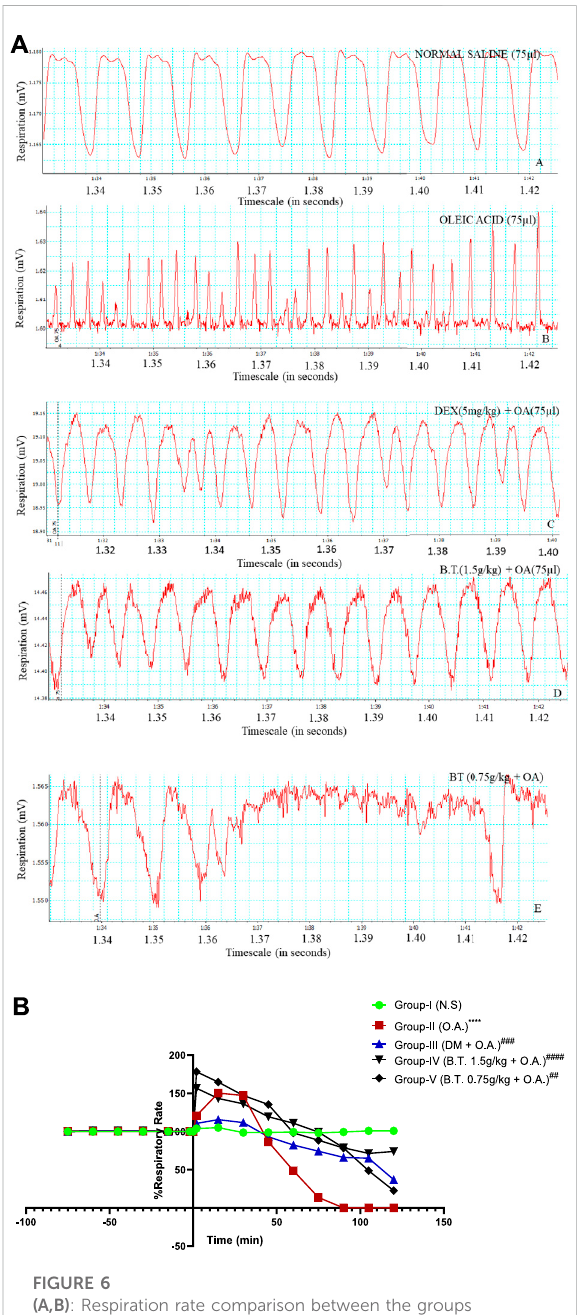
FIGURE 6 (A,B) : Respiration rate comparison between the groups through chart recorder (A) and statistically (B) . (A) : Respiration rate frequency denoted by red colour in real-time in groups I (A), II (B), III (C), IV (D) and V (E) at a 10:1 aspect ratio obtained from a computerized chart recorder where x -axis represents Respiration (mV) and y -axis represent timeline. Group I shows the basal value of RR, whereas tachypnea is prominent in group II. This was recti fi ed in treatment groups III and IV as near normal frequency canbeseenafterinstillationofoleicacid(denotedbyadottedline) instillation. (B) : Respiration rate calculated as percentage initial at 0 min(denotesthetimeofoleicacidinstillationexceptforgroupI). Results are expressed as mean ± SD (n = 6). Statistical analysis was carried out using one-sample T-test and Wilcoxon test where *, p < 0.05, ***, p < 0.001,****, p < 0.0001 in comparison to group I and # ,p < 0.05, ### ,p < 0.001 and #### ,p < 0.0001 in comparison to group II.